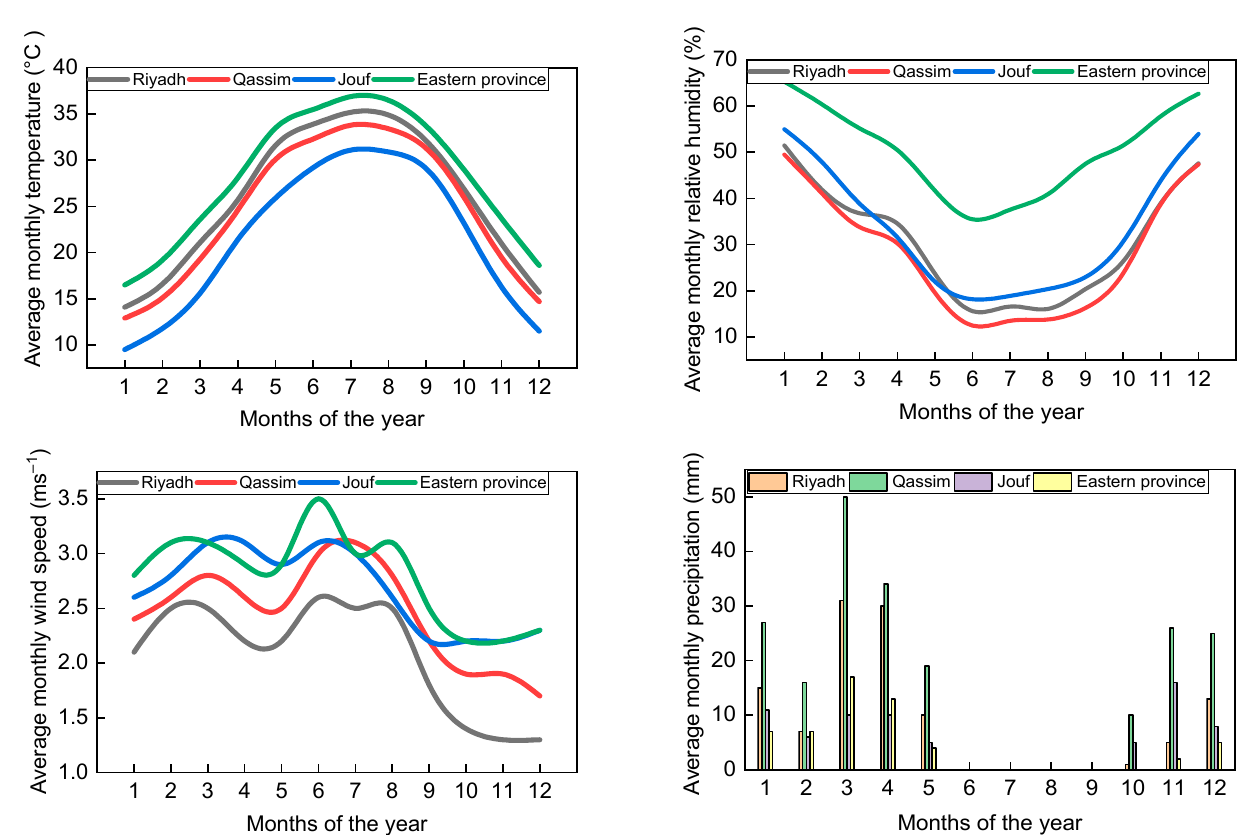
Figure 2. Monthly average climate data for Riyadh, Qassim, Jouf, and the eastern province regions.